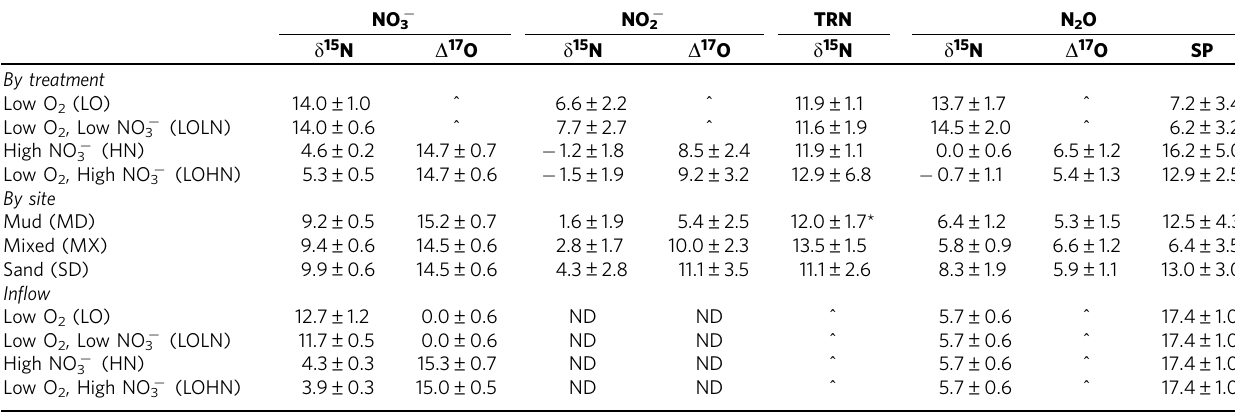
Table 2 | Steady state isotopic composition of measured nitrogen